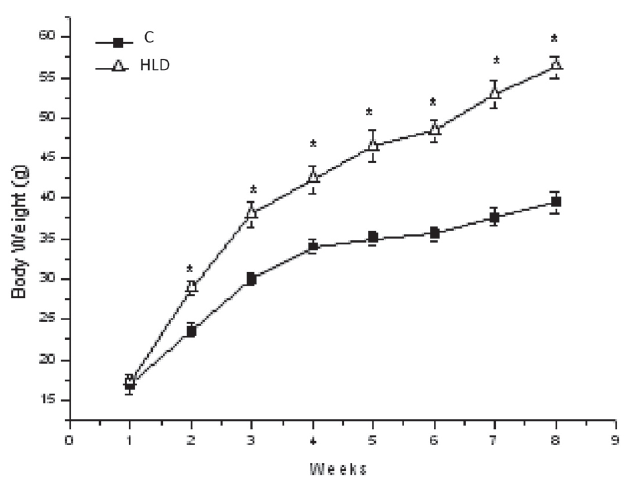
FIGURE 1 - Body weight of mice fed a controle diet (C) or a high fat diet (HFD) for 8 weeks. Results are mean ± standard error (n= 6). * versus C (P<0.05). TABLE II - Adipose tissue depots (g) (retroperitoneal (RET) and epididimal (EPD) of mice fed with a control diet (C) or a high fat diet (HFD) for 8 weeks. Results are mean ± standard error (n= 6). *versus C (p<0,05)